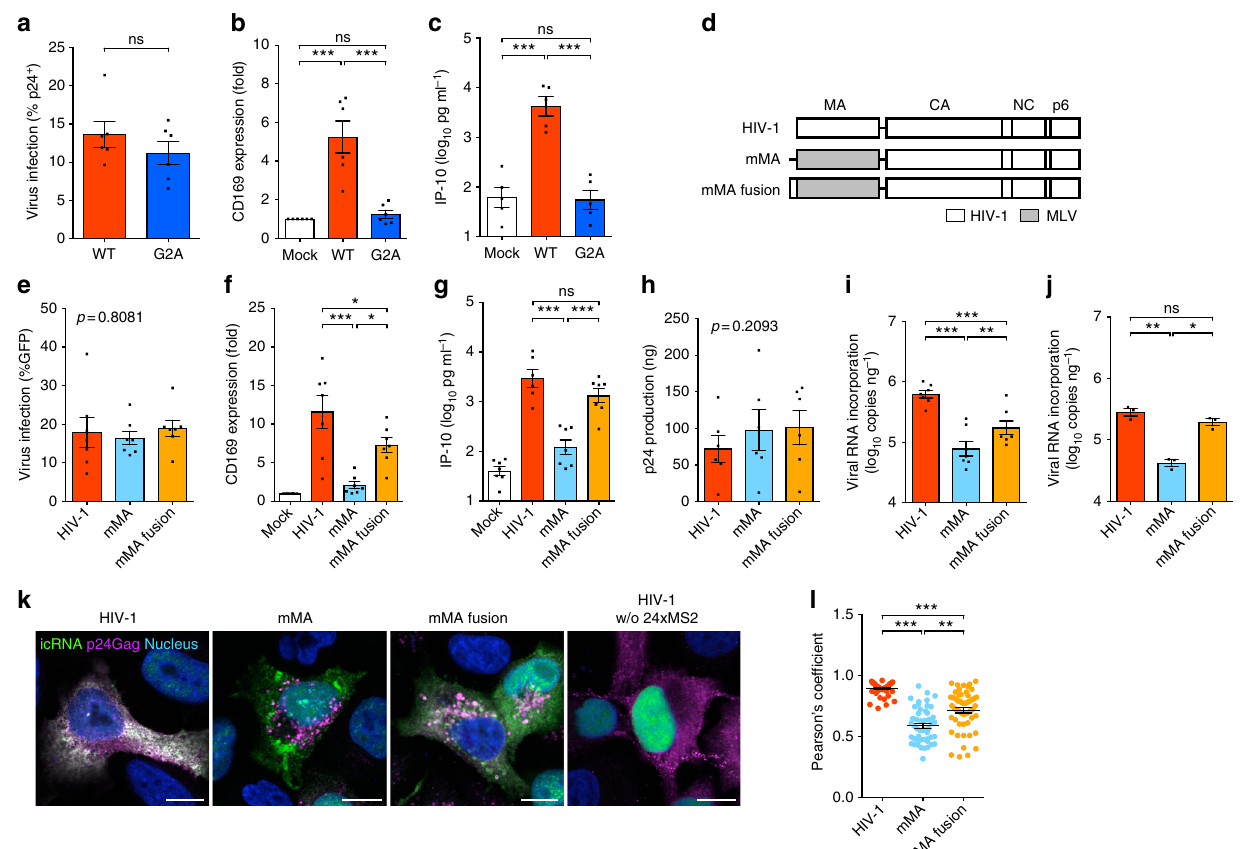
Fig. 4 Membrane targeting of viral icRNA is required for MDM activation. a – c Gag (viral) expression ( a ) CD169 expression ( b ) and IP-10 production ( c ) in wild type (WT) or Gag-G2A-infected (MOI of 2) MDMs on day 6 post infection. d – h Schematic of MLV/HIV-1 chimeras ( d ) and infection ( e ), CD169 expression ( f ), IP-10 production ( g ), and virion production ( h ) in MDMs. MDMs were infected with HIV-1 mutants at MOI of 1 and examined on day 6 post infection. i , j Viral RNA incorporation in MDM-derived ( i ) and HeLa-derived ( j ) virions. Virus-containing culture supernatants were harvested on day 6 post infection and virion-associated genomic viral RNA per ng p24 Gag was quanti fi ed. k , l Co-localization of p24 Gag and intron-containing viral RNA ( k ) and its quanti fi cation ( l ) in HeLa. Scale bar: 10 µ m. The means ± SEM are shown and each symbol represents an independent experiment. Two-tailed p -values: one-way ANOVA followed by the Tukey-Kramer post-test ( b , c , f , g , i , and j ), a Kruskal – Wallis test followed by the Dunn ’ s post-test ( l ), or paired t